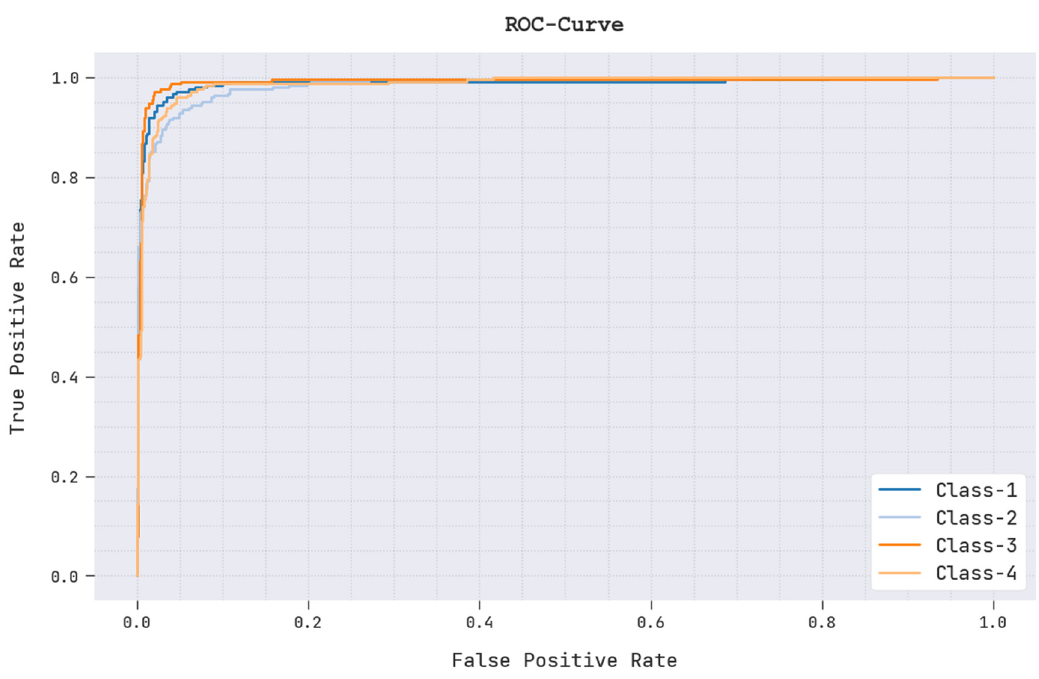
Figure 10. ROC curve analysis of AOTL-CDA3S system.